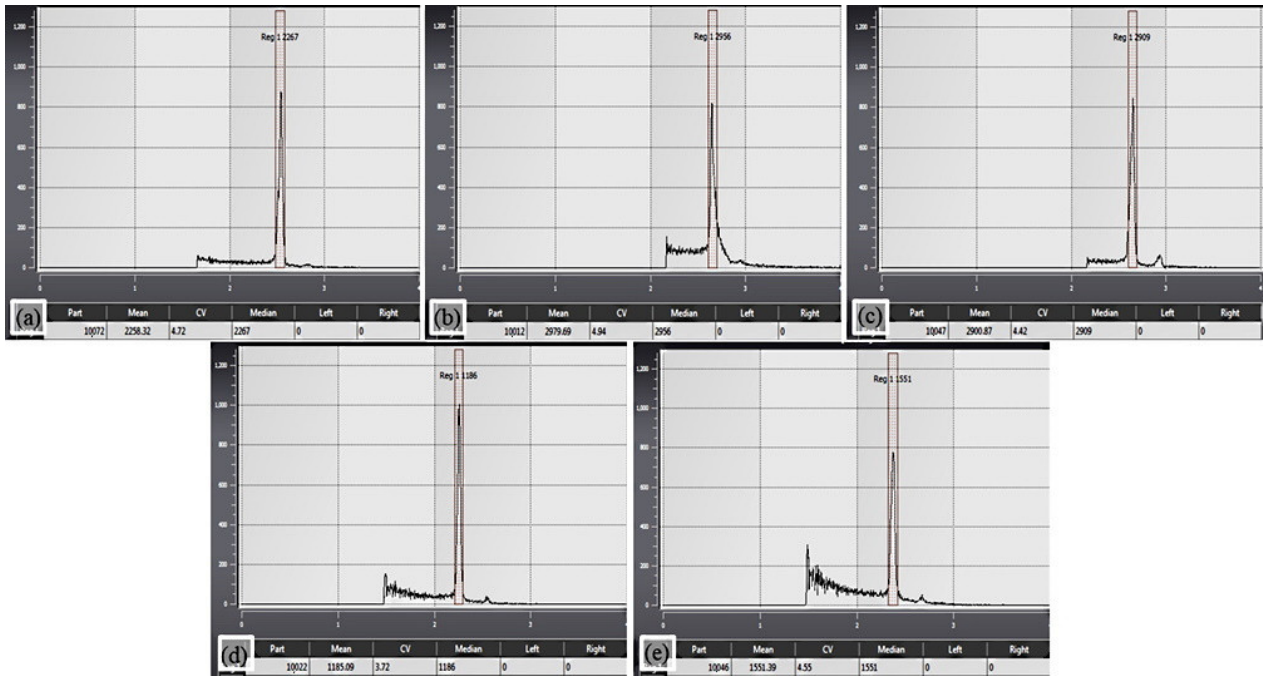
Figure 6. Histograms of the ploidy level of the analyzed H. officinalis f. cyaneus material: ( a , d )—external control, ( b )—samples of nuclei from plant leaves ex situ, ( c )—samples of nuclei from leaves of microshoots in vitro (0.8 mg/l BAP), ( e )—samples of nuclei from leaves of microshoots in vitro (0.3 mg/l BAP).